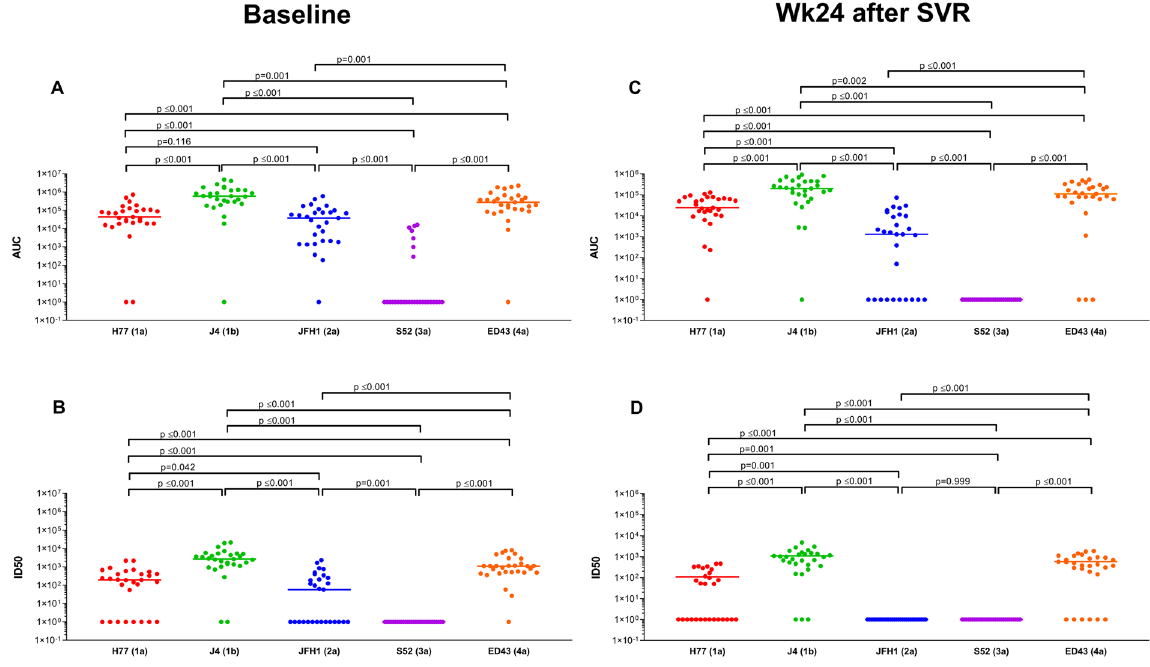
Figure 1. Summary of the neutralization potency of HCV antibodies against recombinant viruses in HIV/ HCV-coinfected patients, at baseline and 24 weeks after sustained virological response. Individual (circles) and median values (short horizontal bars) are represented. Abbreviations: AUC, area under the curve (arbitrary units); ID50, 50% inhibitory dose; SVR, sustained virological response; Wk, week. Statistics: p-values were calculated by the Wilcoxon